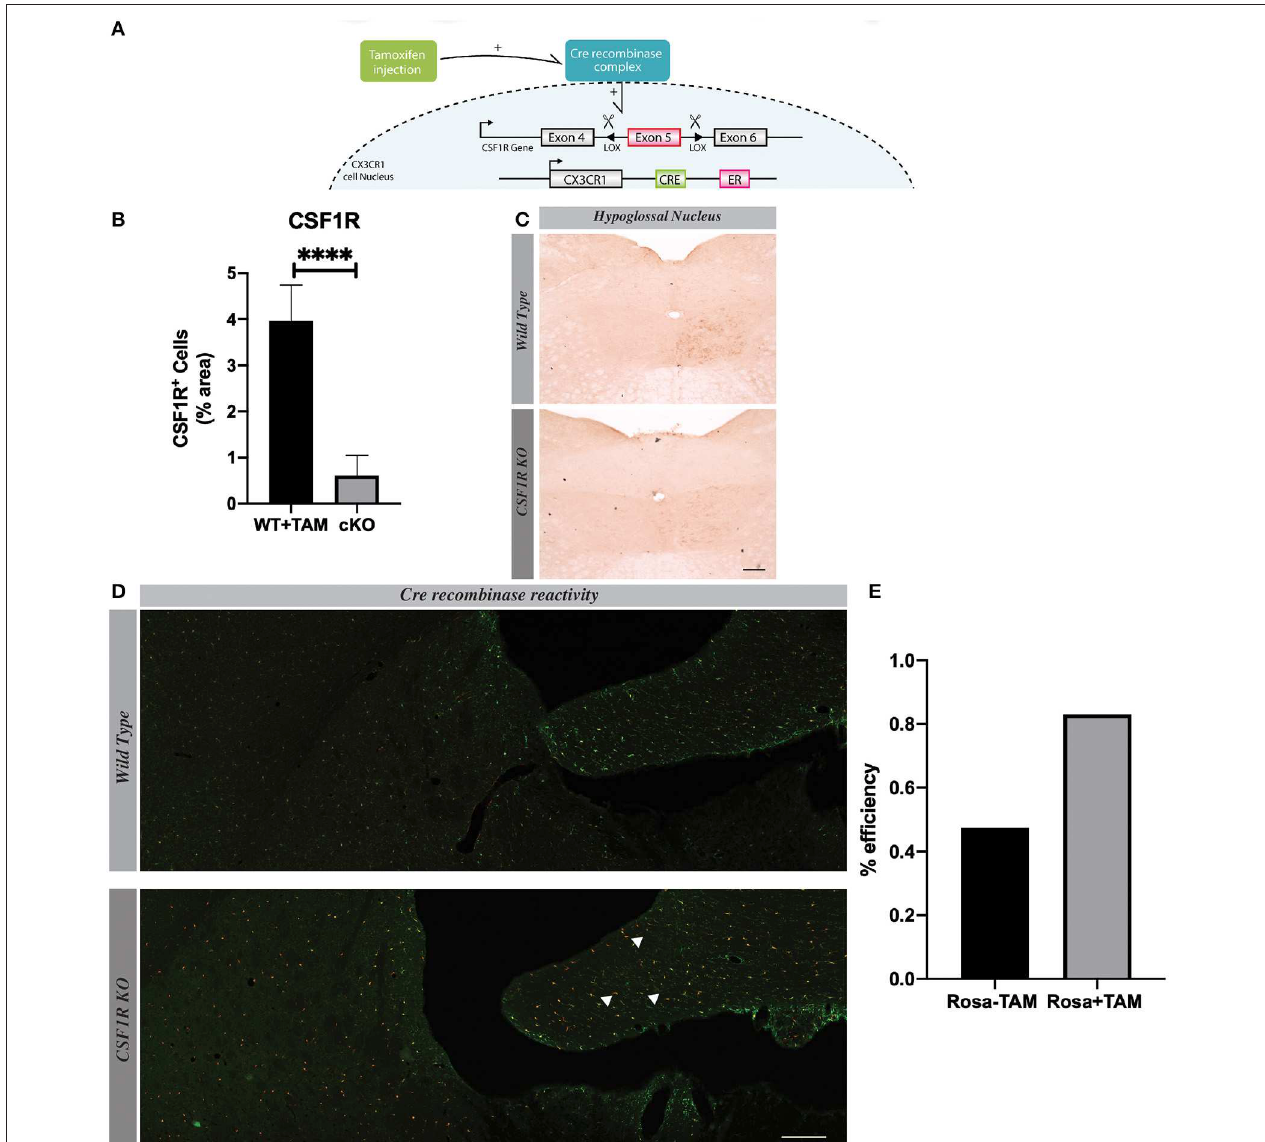
FIGURE 1 | CSF1R is deleted specifically in microglia. (A) We Show the genetic construction of CSF1R Ko mice. (B) Quantification presented as percentage of area occupied by staining, measured in the hypoglossal nucleus. Values are expressed as means ± SEM. Statistical analyses were performed using t -test **** p < 0.001 significantly different from cKO group. (C) Representative images of CSF1R staining in hypoglossal nucleus 7 days after lesion. (D) Confocal images showing co-localization of RedTomato positive cells (red) with Iba1 immunoreactive cells (green). (E) Quantification of RedTomato staining. Mice were injected with tamoxifen. White arrows point-out some examples of co-localization. n = 7 mice. Scale bar 200 µ